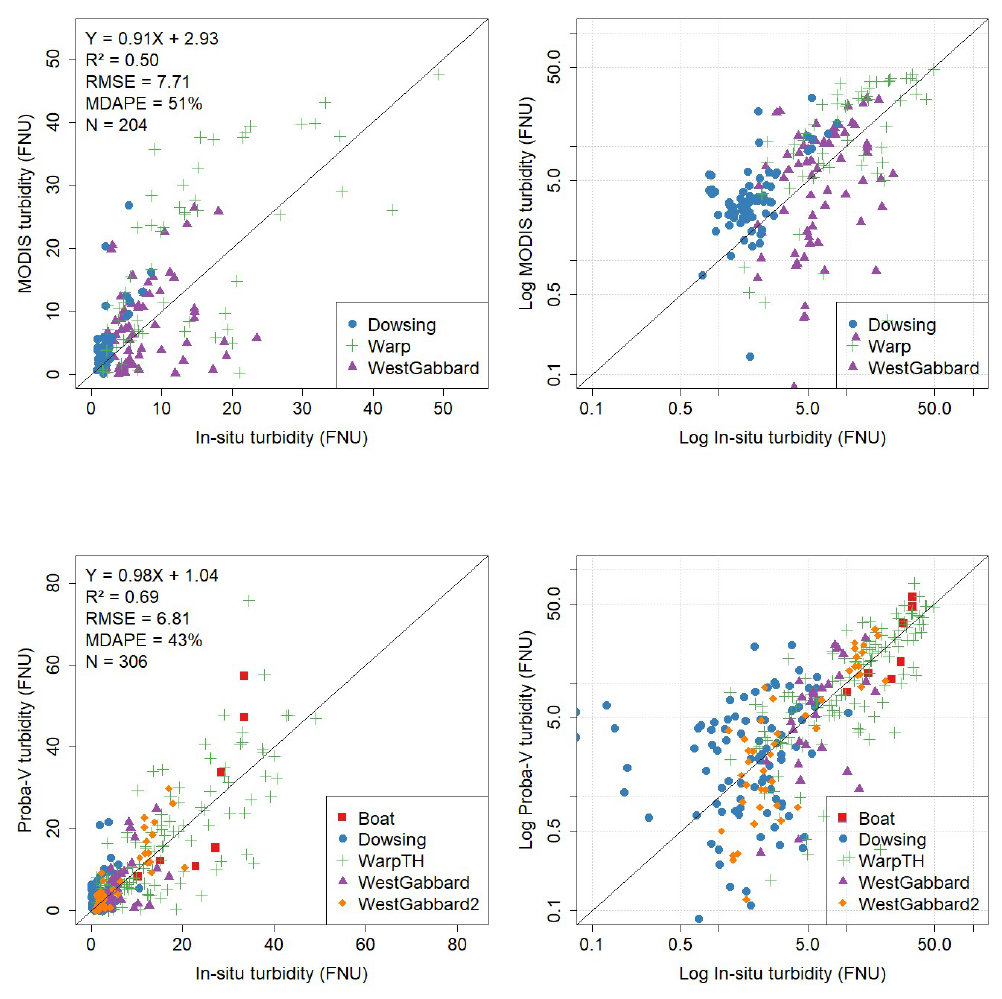
Figure 7. Regression plots between in-situ turbidity measurements (SmartBuoys and field data) and (top) MODIS or (bottom) PROBA-V derived turbidity values. On the left linear plots are given with the statistics (R² = coefficient of determination, RMSE = Root Mean Square Error, MDAPE = Median Absolute Percentage Error, N = Number of observations). On the right, the data are plotted on a logarithmic scale. The solid black line is the 1:1 line.